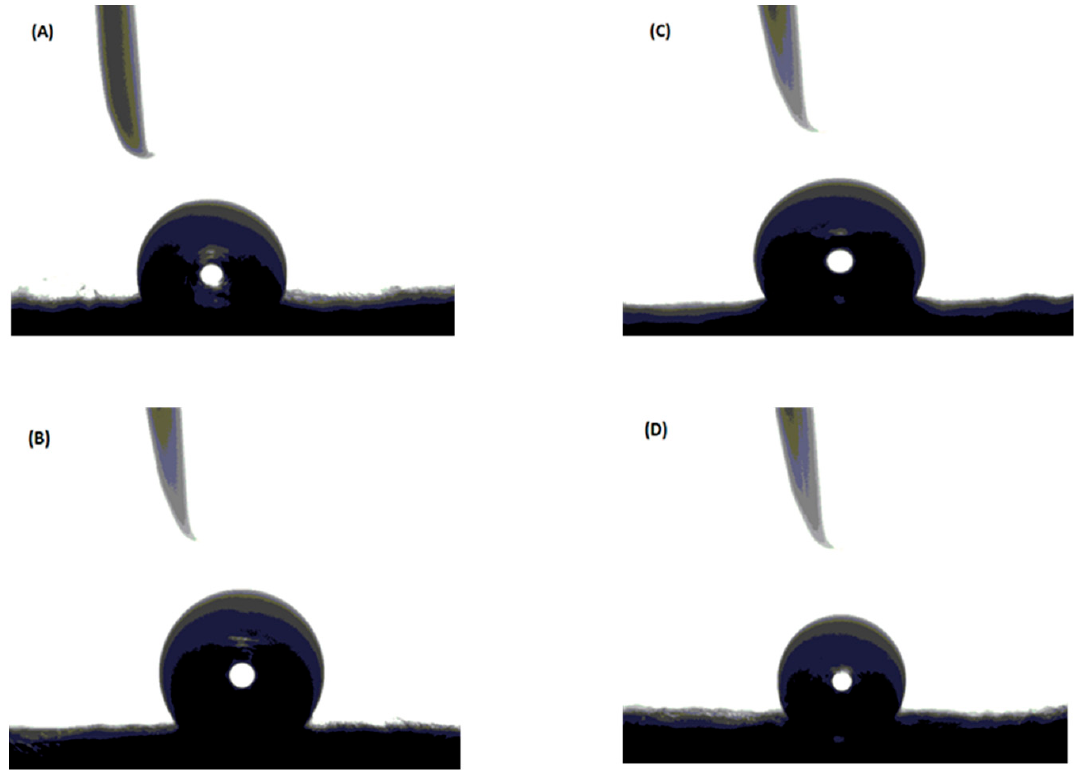
Figure 4. Contact angle for: ( A ) Blank PS membrane ( B ) Composite PS/GNPs membrane with 0.25 wt.% ( C ) Composite